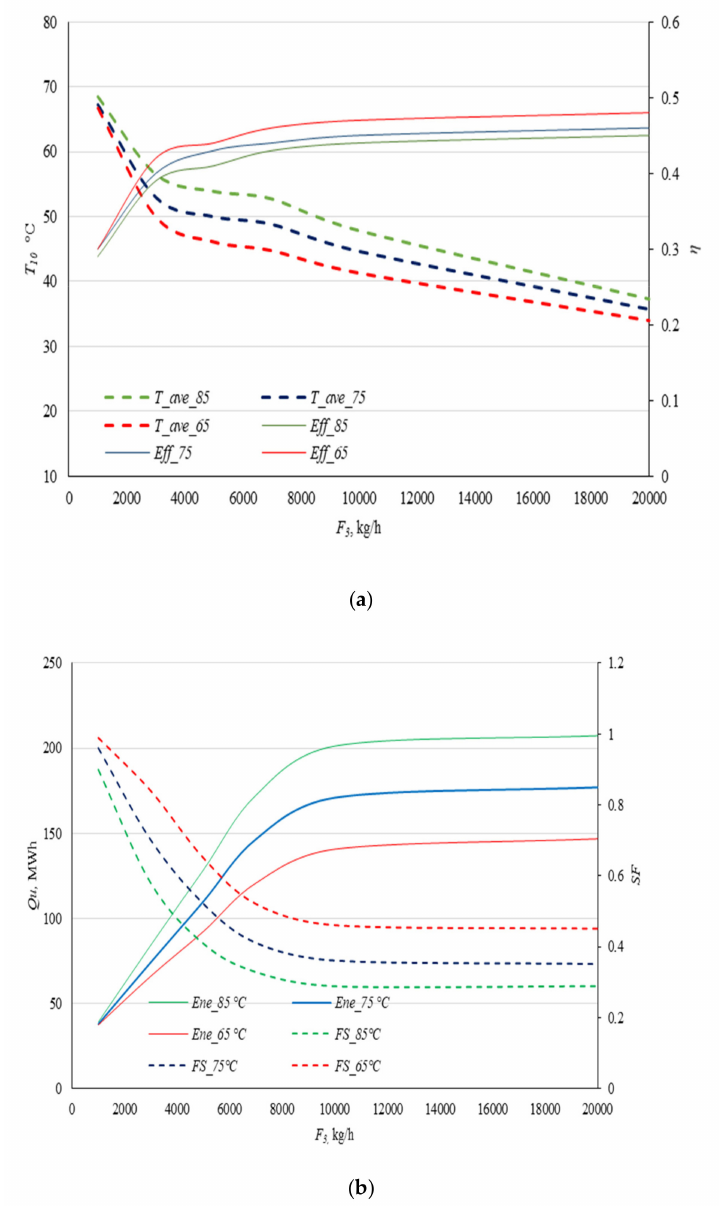
Figure 12. Parametric study. ( a ) Temperature T 10 vs. Efficiency η ; ( b ) Q u vs. SF . The annual thermal efficiency and flow rate relationship was almost linear between 1000–4000 kg/h; the annual efficiency changes concerning the flow rate were up to 7000 kg/h. On the other hand, the annual efficiency changes due to the auxiliary heater set point pre- sented an average variation of 2.0%. Thus, the annual efficiency was more sensitive to the flow rate than the auxiliary heater set point temperature, and the drying temperature was affected by both flow rate and auxiliary heater set point temperature. In the same way, the annual solar fraction increased, and the yearly useful energy decreased almost linearly between 1000–4000